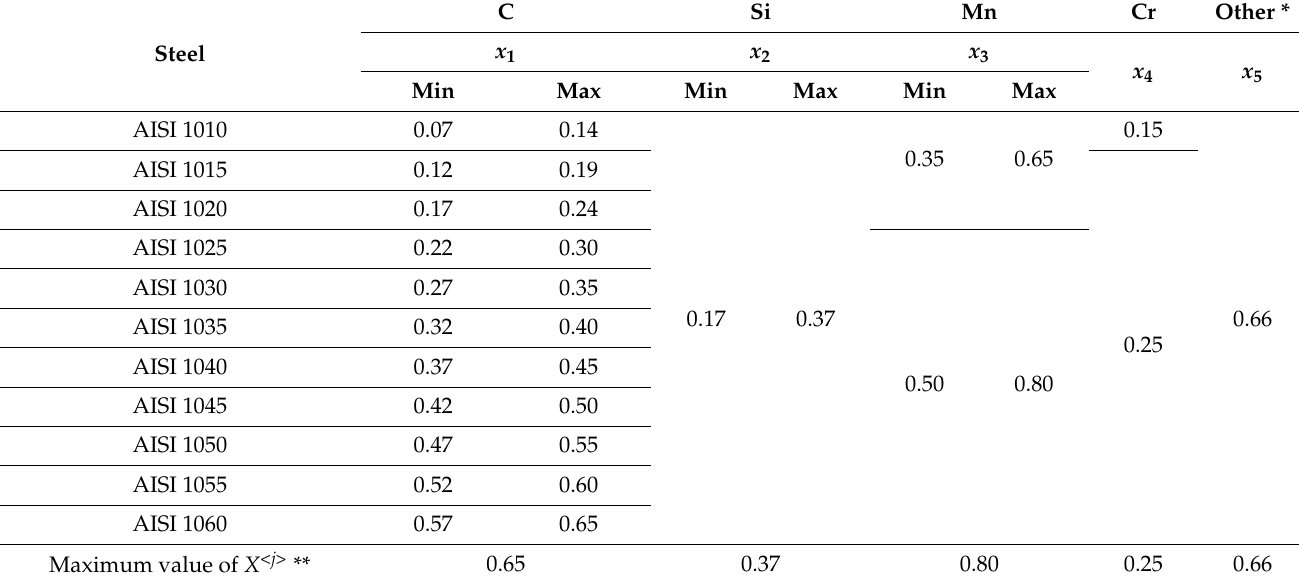
Table 1. The chemical composition of carbon steels, %. Adapted from